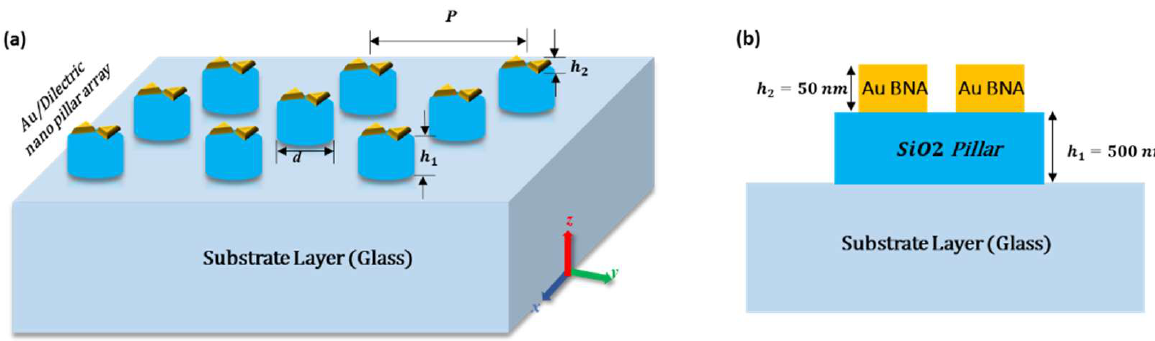
Figure 1 . ( a ) A schematic view of the periodic array of Au bowtie nanoantennas (BNA) on SiO 2 nanopillar arrays placed on a quartz substrate; ( b ) A two-dimensional view of the plasmonic system under investigation (the final optimized geometrical dimensions are shown).